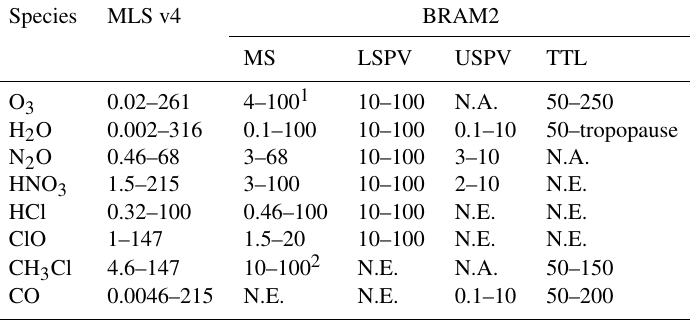
Table 4. Vertical ranges of validity (hPa) of MLS v4 assimilated species and the corresponding BRAM2 products in the middle strato- sphere (MS), the lower-stratospheric polar vortex (LSPV), the upper-stratospheric–lower-mesospheric polar vortex (USPV) and the tropical tropopause layer (TTL). Abbreviations: not evaluated (N.E.) and not assimilated